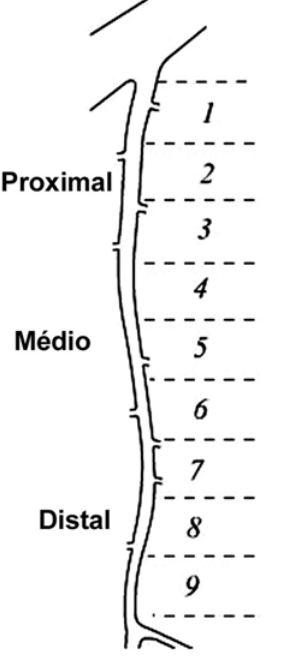
Fig. 1 - O comprimento total da artéria torácica interna esquerda, da sua origem até a bifurcação, foi dividido em nove segmentos